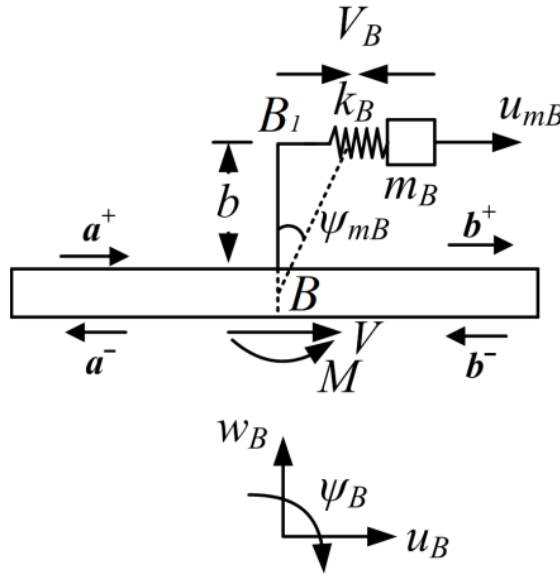
Figure 7. A host beam with a longitudinal-force-moment type resonator. The free body diagram of the resonator is shown in Figure 8. In the figure, u mB and ψ mB are the axial deflections of the mass blocks m B and angular rotation of the beam BB 1 , respectively. V B is the longitudinal force caused by the spring. The production of longitudinal force V and bending moment M are generated from the resonator, which are applied on the host beam, respectively. At point B on the beam, the deflection of transverse, axial and angular rotation are w A , u A , and ψ A , respectively. Note that the transverse w A is not involved because of no generation of transverse force of this type of resonator to the host beam.